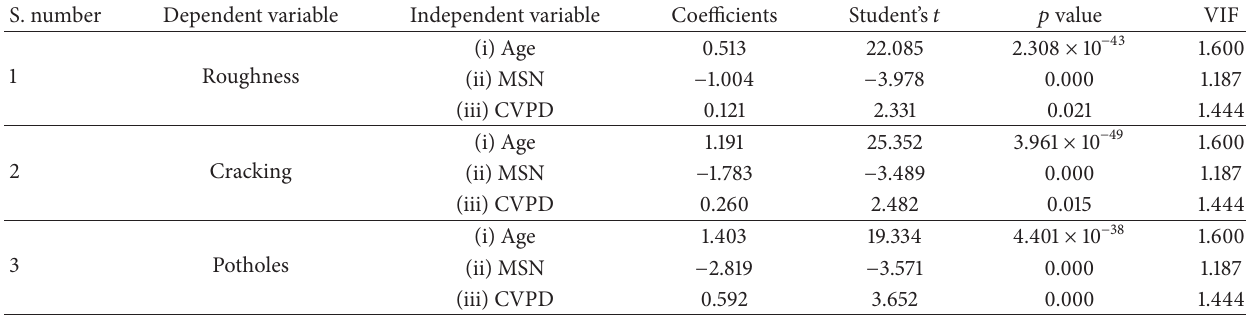
Table 3: Statistics of the performance prediction models.